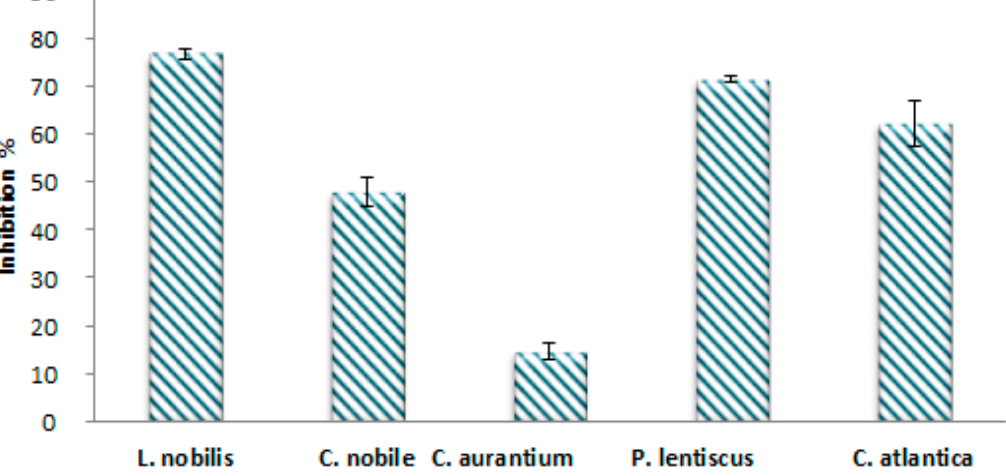
Figure 5. Percentage of inhibition of DPPH° by EOs of plants species.